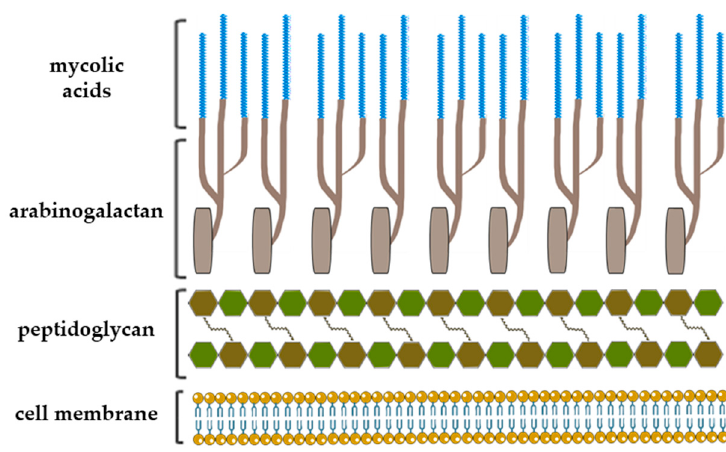
Figure 2. A schematic representation of the Mycobacterium tuberculosis cell wall structure with depiction of the three major cell wall features, including peptidoglycan, arabinogalactan and mycolic acids [13,14]. Arabinogalactan is a cell wall core assembly composed of arabinofuranose and